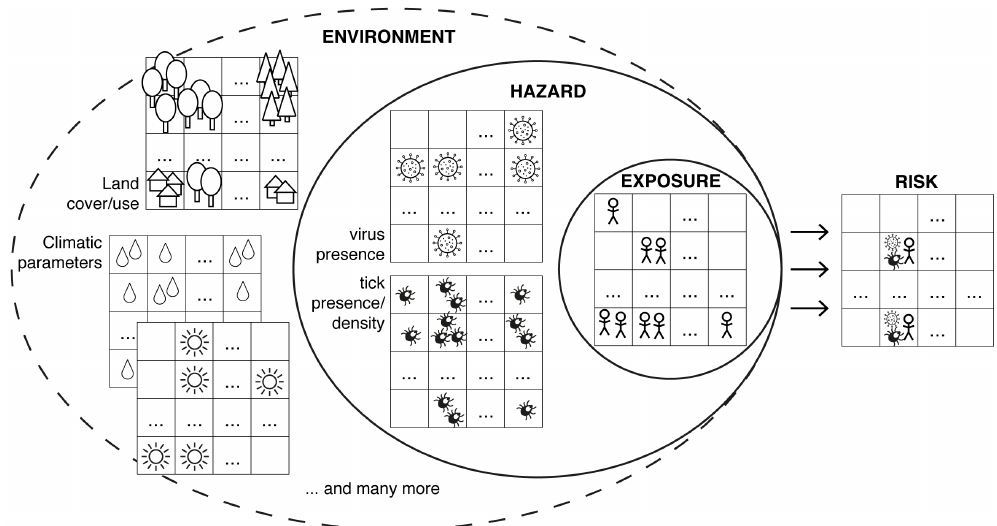
Figure 1. Assessing the spatial risk for human tick-borne encephalitis results from a combination of hazard (virus presence and tick presence/density) and exposure (e.g., human outdoor activity, vaccination rate) triggered by abiotic and biotic